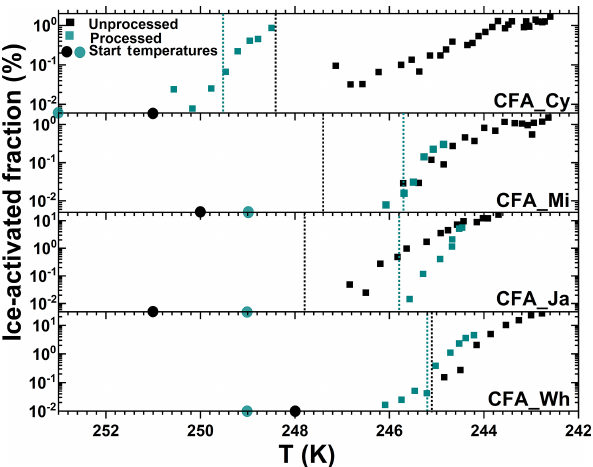
Figure 7. Summary of the ice-activated fraction (%) of unprocessed and processed CFA_Cy (5 and 15), CFA_Mi (8 and 23), CFA_Ja (6 and 17), and CFA_Wh (7 and 20) particles as a function of tempera- ture. The numbers in the brackets are the corresponding experiment numbers in Table 2. The black data points show experiments be- fore the temperature-cycling and freezing (TCF) procedure, and the cyan data points represent experiments after the TCF process. The dotted lines correspond to the temperature where water saturation was reached for each experiment.